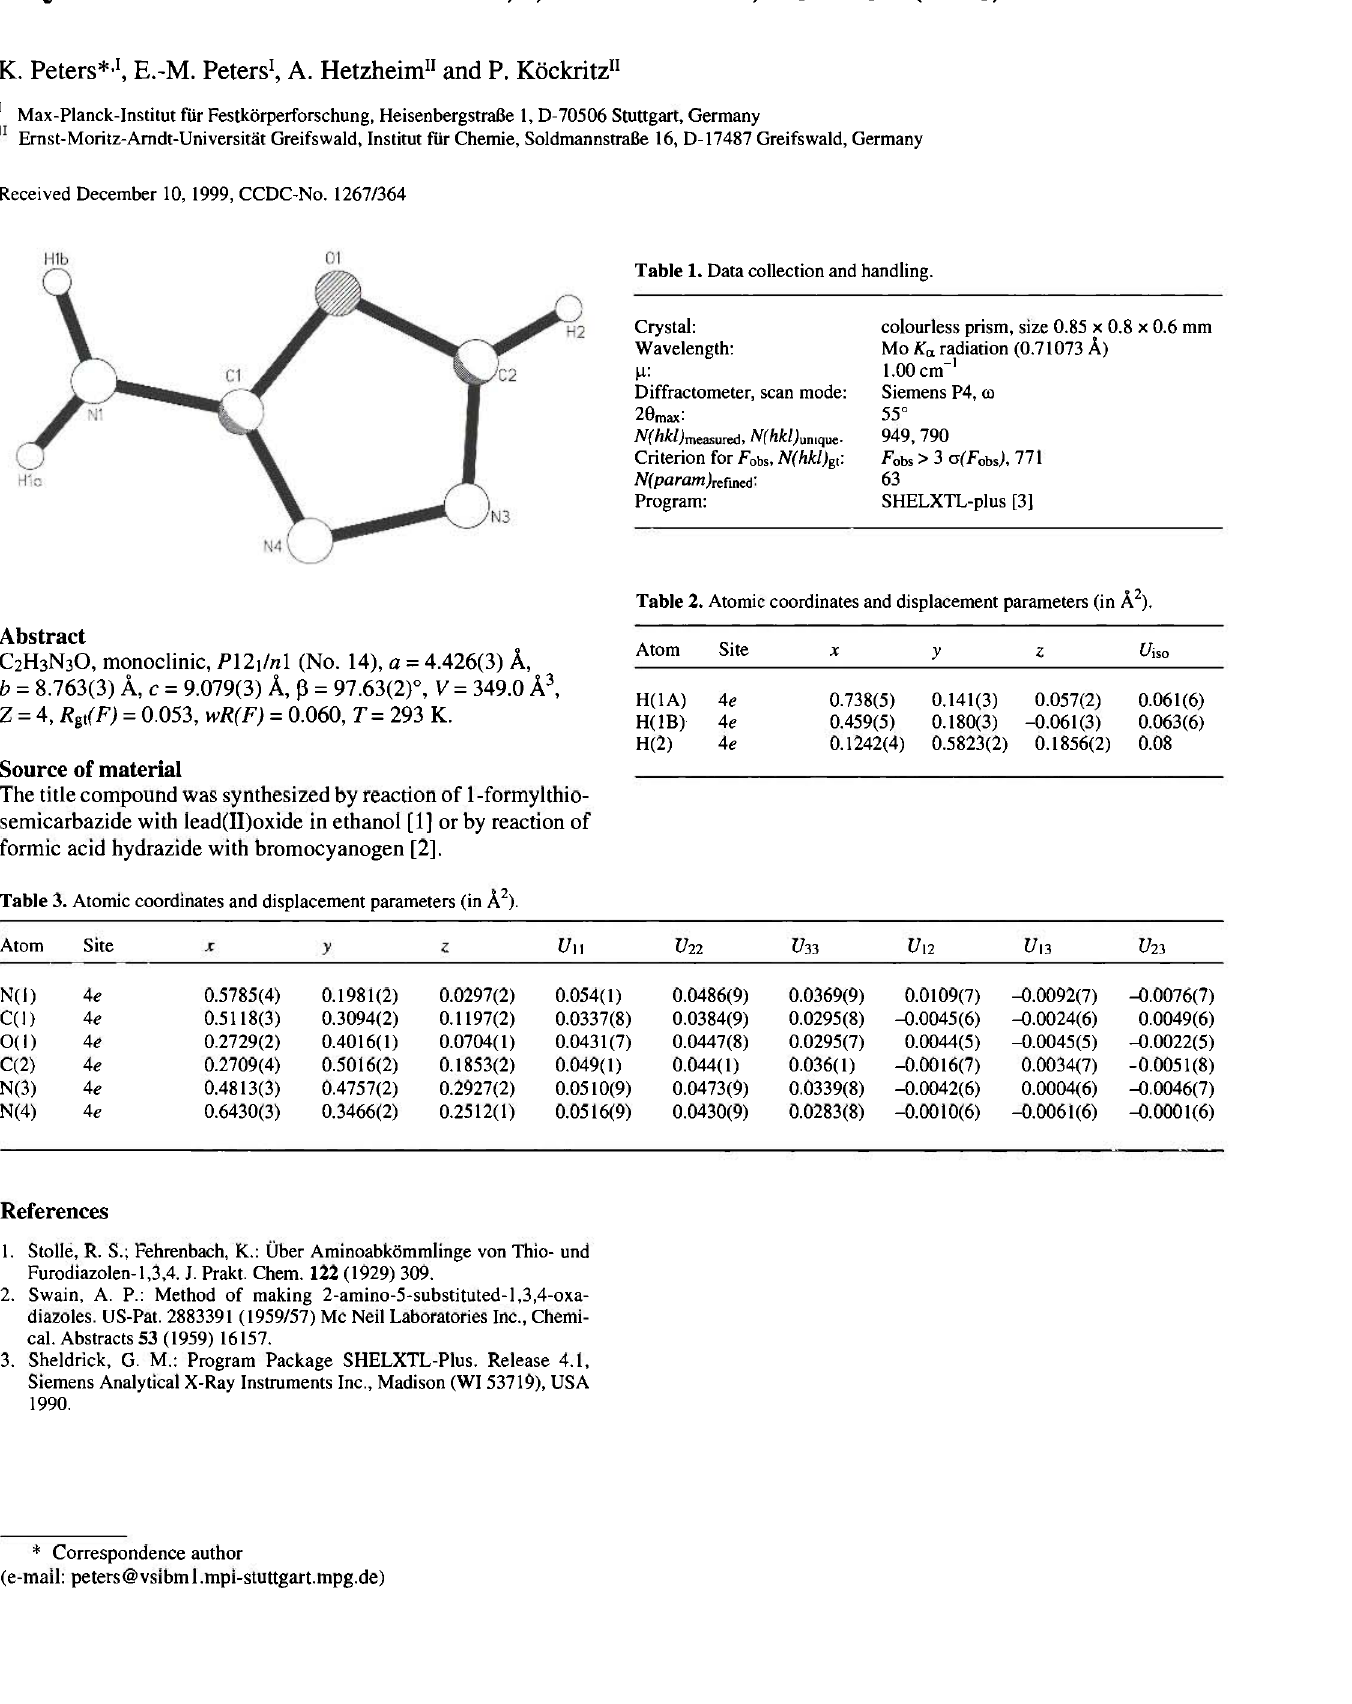
Table 1. Data collection and handling.